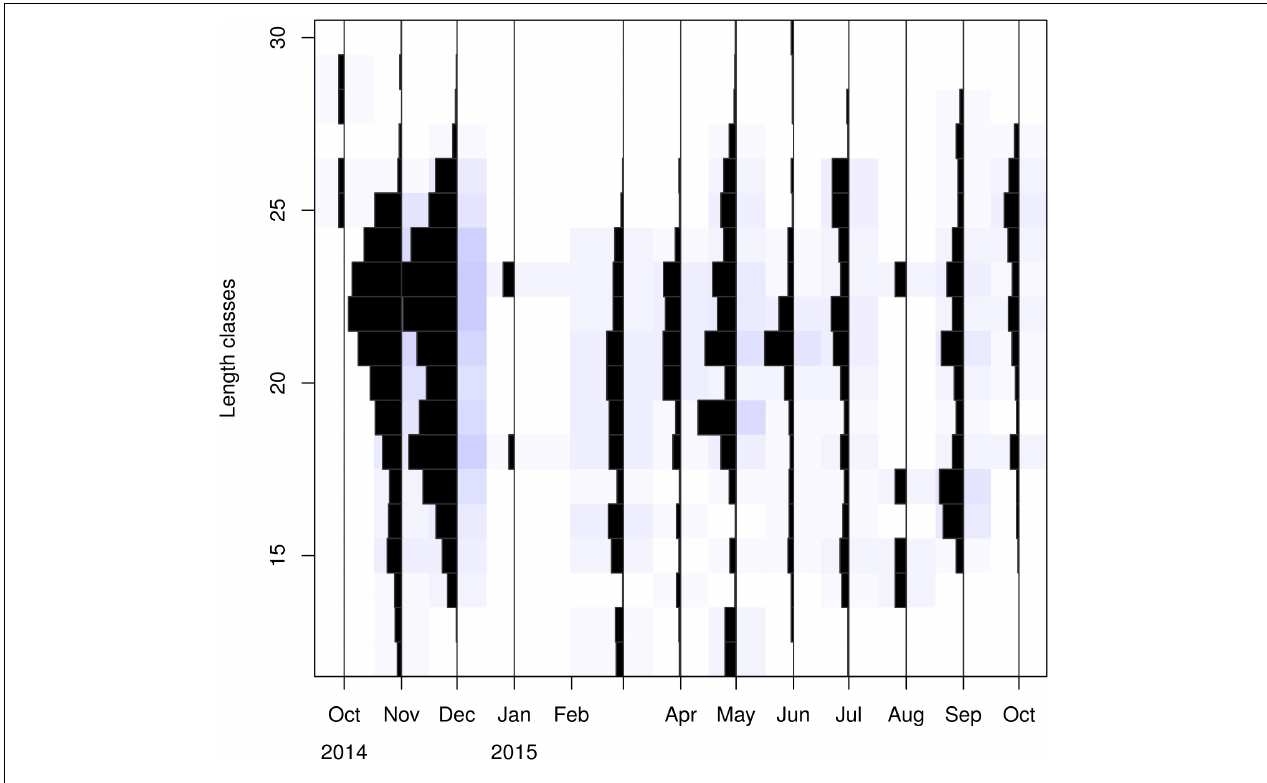
FIGURE 3 | The LFDs analyzed by ELEFAN. Length classes (CL) are in mm. TABLE 3 | Main settings adopted in running the ELEFAN analysis in terms of L inf and K range, initial t anchor value and Moving Average (MA) and main correspondent outputs. Methods to estimate L inf range MA L inf